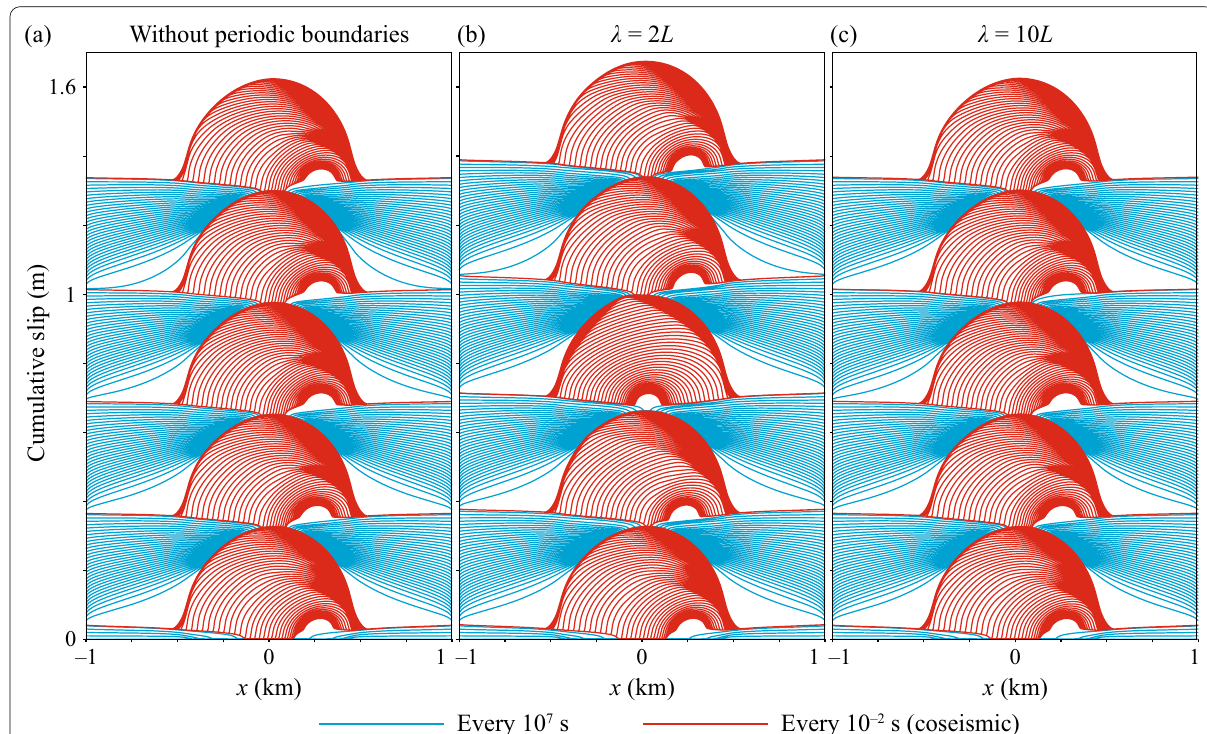
2 L , and c (cid:31) 10 L , where L 2 km . Blue and red = = =